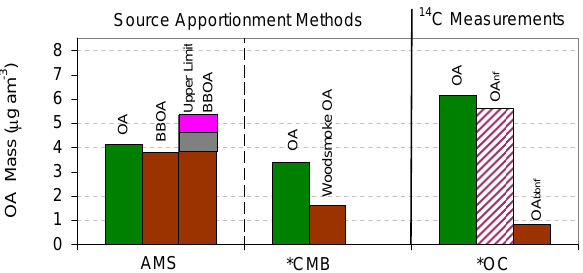
represents bulk OA, brown represents biomass burning OA, grey and pink represent potential additional BBOA contained in the PMF HOA and OOA respectively, and striped brown is used for the non-fossil 14C measurement. (*Carbon measurements converted to OA using an OA/OC value of 1.6.)